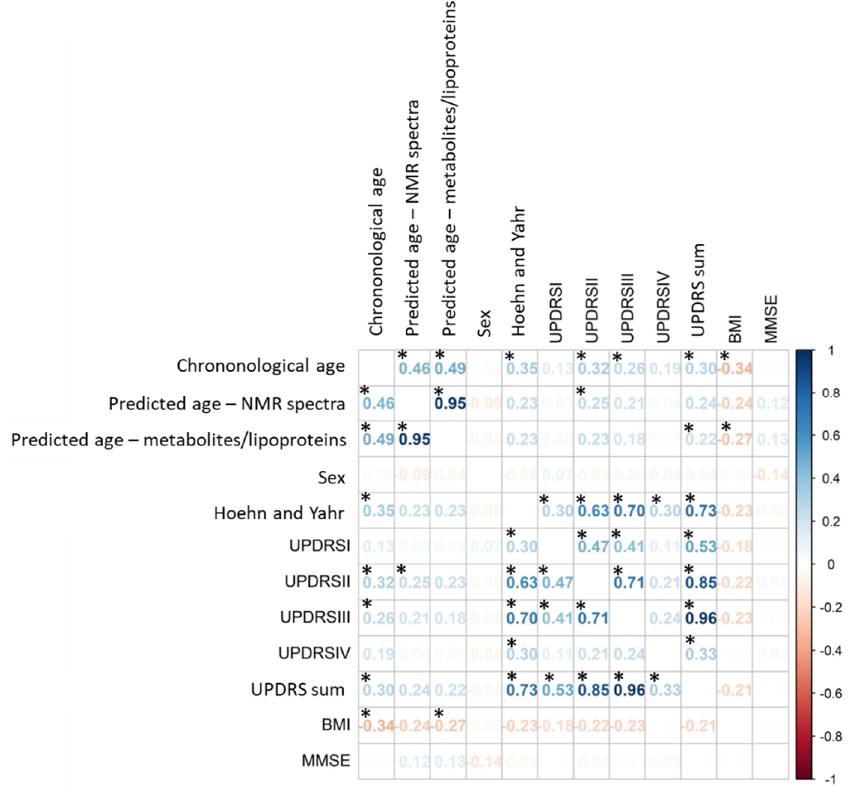
Figure 3. Pearson’s correlation coefficients among predicted age (estimated using PLS), severity scores, and other demographic and physiological variables. Data are obtained using the dn 2 PD cohort. Asterisks represent p -values < 0.05.